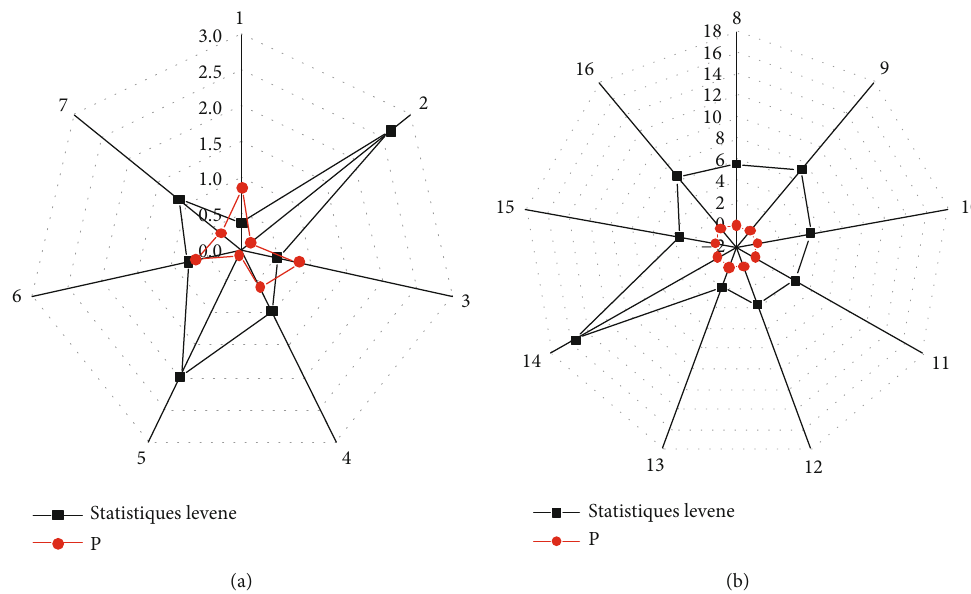
Figure 6: Homogeneity of variance between mother ’ s education level and college students ’ mental health (1: autonomy; 2: environmental control; 3: personal growth; 4: positive relationships with others; 5: life goal; 6: self-a ffi rmation; 7: total score of PWB; 8: somatization; 9: obsessive-compulsive; 10: interpersonal relationship sensitivity; 11: depression; 12: antagonism; 13: scariness; 14: paranoia; 15: psychosis; 16: total score of